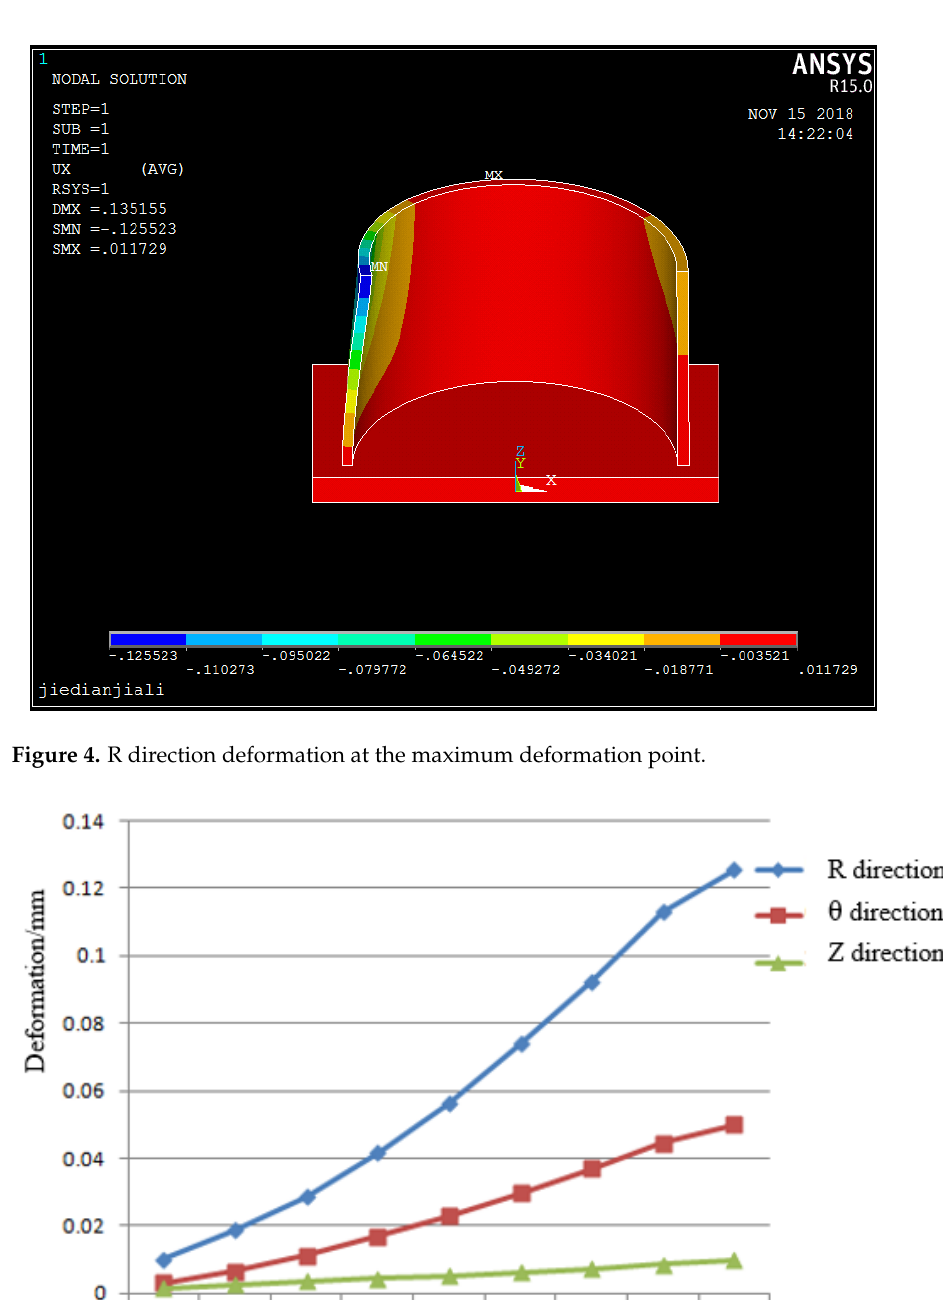
4 of 13 Figure 3. Deformation in three directions at different machining positions. 2.3. Analysis of Machining Deformation Results Because the radius of the workpiece is much greater than the thickness of the thin- walled part, the length of the cutting edge of the tool is much less than the height of the workpiece. When the tool is cutting on the workpiece, the cutting force line load of the